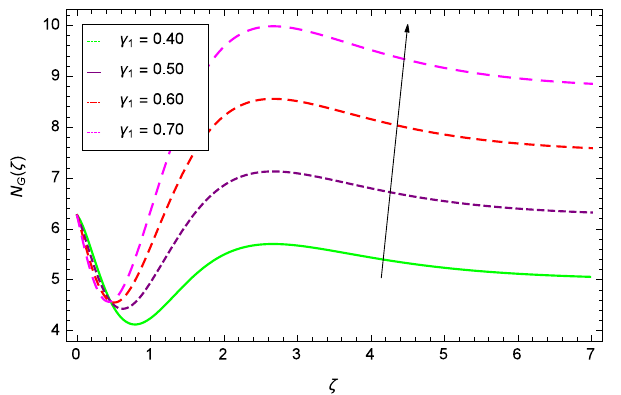
Figure 39. Parameter effect on entropy generation rate N G ( ζ )